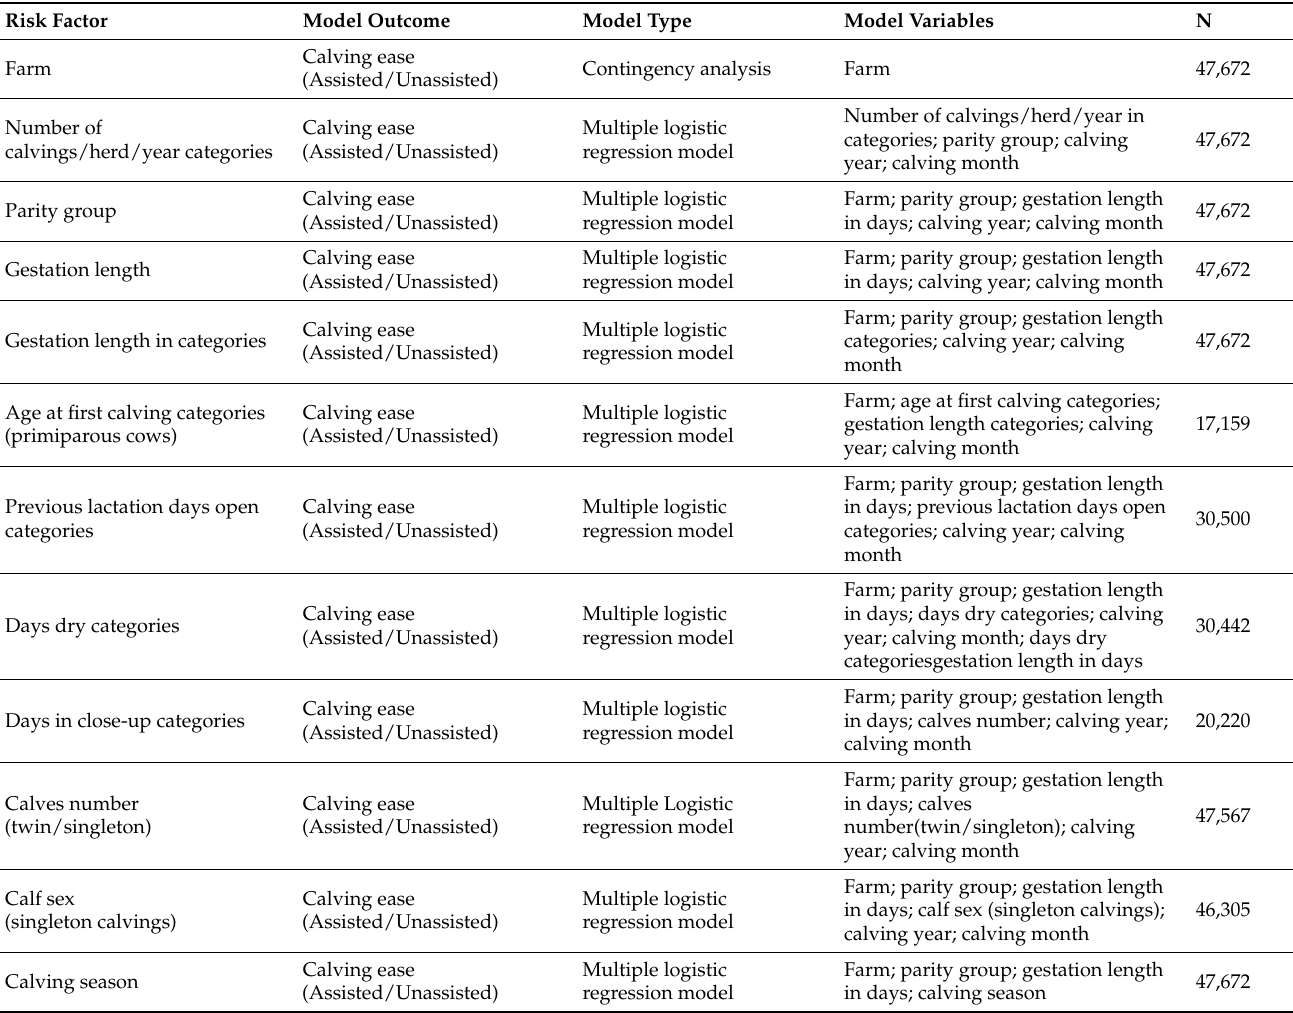
Table 1. Description of statistical model and variables included for each risk factor considered in the study.